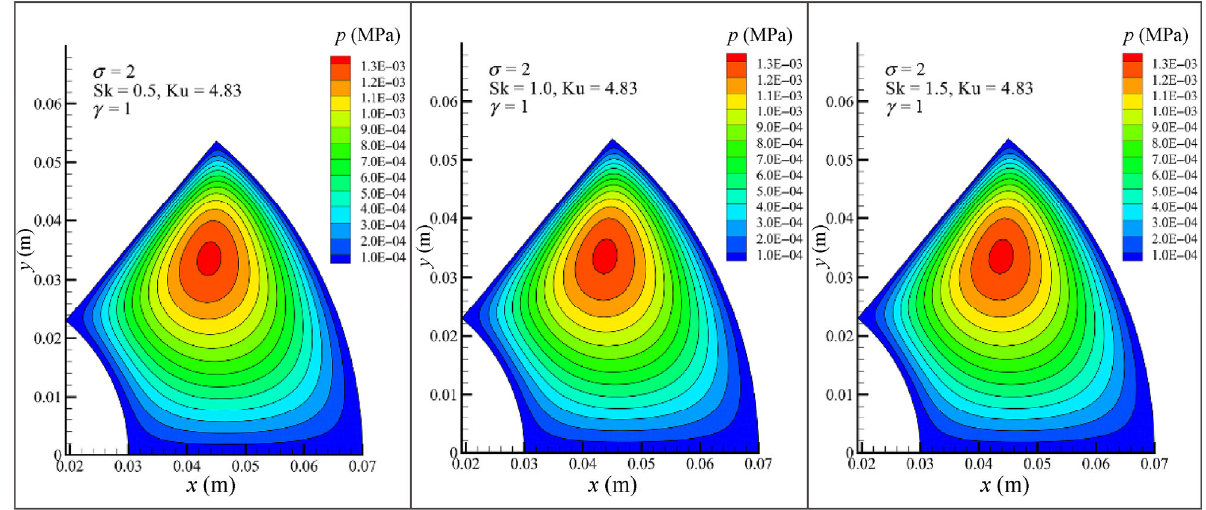
Fig. 6 Average fluid pressure distributions with various Sk. Ku = 4.83,